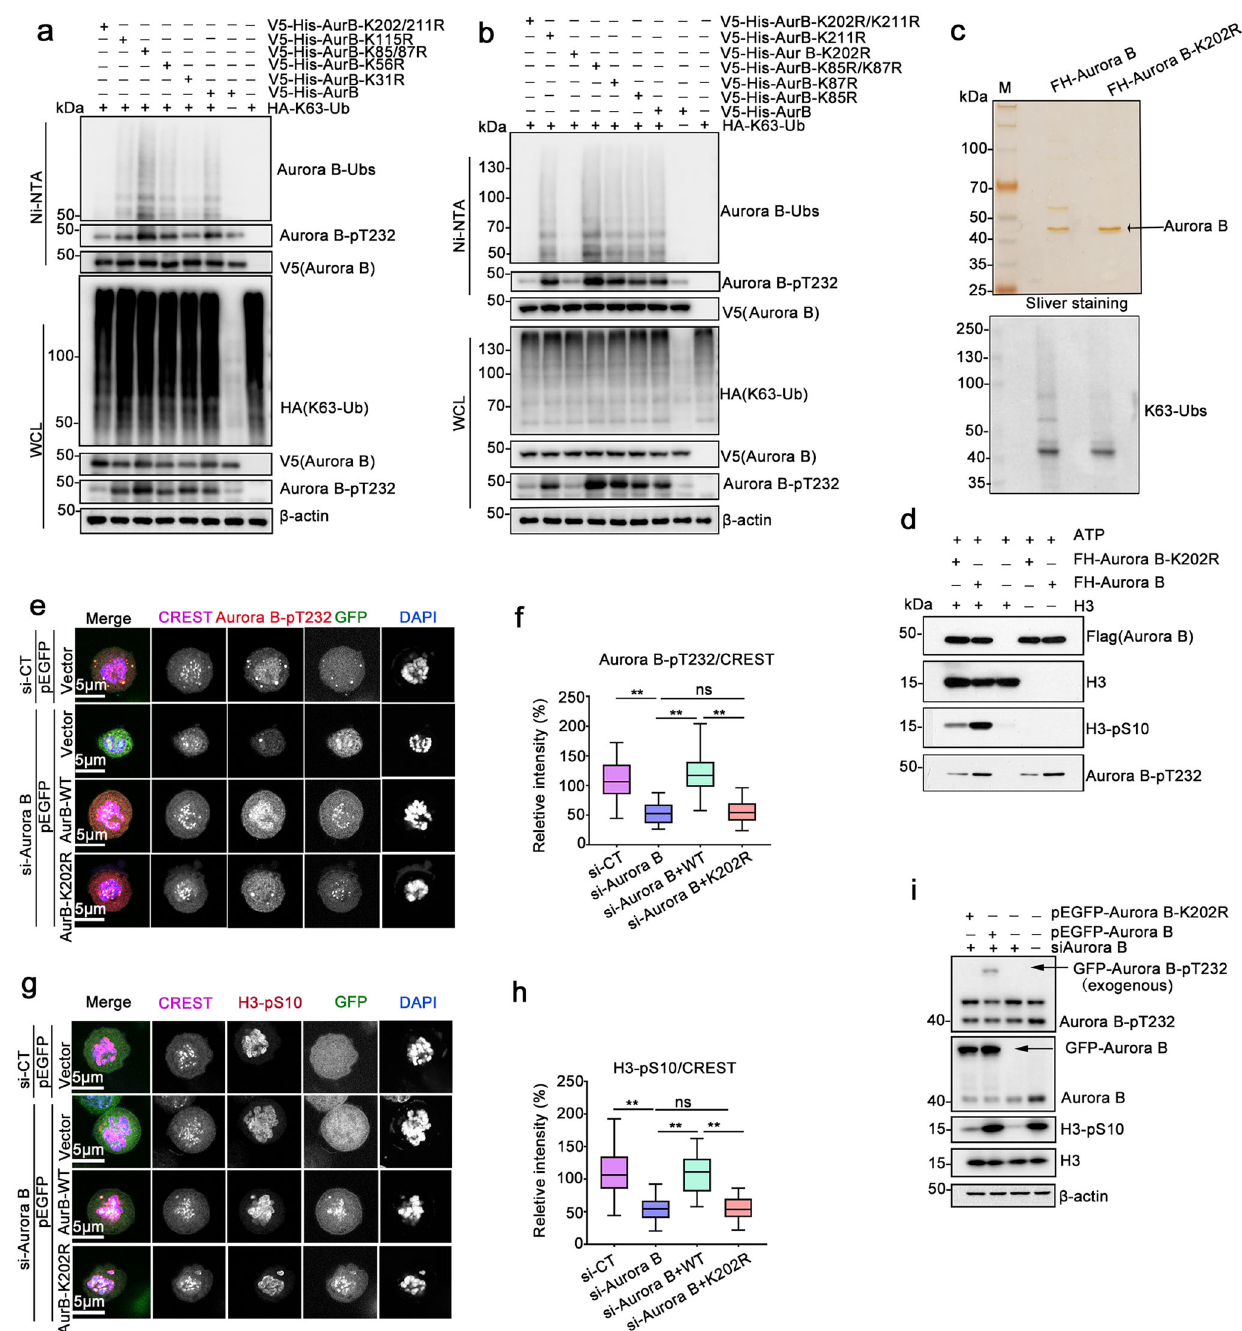
Fig. 4 K63-linked ubiquitination at Lys202 is required for Aurora B kinase activity. a , b K202 is the main ubiquitination site on Aurora B. HEK293T cells were co-transfected with the indicated plasmids and treated with 30 ng/mL NOC for 16 h. Mitotic cells were subjected to Ni-NTA pull-down under denaturing conditions. V5-His-Aurora B pull-downs were analyzed by immunoblotting with the indicated antibodies. c Immunoprecipitations used in the in vitro kinase assay. FH-Aurora B or FH-Aurora B-K202R was puri fi ed from mitotic HEK293T cells using Flag-M2 agarose beads, resolved by SDS – PAGE and silver staining (upper), and immunoblotted with anti-K63-Ub antibody (bottom). d In vitro kinase assay was performed using the puri fi ed Aurora B complex shown in c , in the presence of ATP. H3 was used as the substrate of Aurora B. e – i Aurora B-K202R has lower kinase activity in vivo. Representative confocal images showing Aurora B-pT232 ( e ) or H3-pS10 ( g ) intensity in cells transfected with pEGFP-Aurora B or pEGFP-Aurora B-K202R. Endogenous Aurora B was silenced by siAurora B in HeLa cells, followed by co-transfection with the indicated plasmids. Then cells were synchronized with 30 ng/mL NOC, fi xed, and stained with the indicated antibodies. Aurora B-pT232, red; CREST, purple; DAPI, blue; H3-pS10, red. Bar, 5 μ m. f , h Box-and- whiskers plots showing the quanti fi cation of the relative intensity of Aurora B-pT232 or H3-pS10 as shown in e and g , respectively. Intensities were normalized to the general kinetochore marker CREST. Boxes show the upper and lower quartiles with a line at the median. Whiskers as the extent of 100% of the data. Data are shown as means ± SD ( n = 15 cells, and six areas for each cell were counted). ** p < 0.01 versus CT, one-way ordinary ANOVA test, analyzed by GraphPad Prism 8. Experiments were repeated at least three times. i Protein samples from cells treated as shown in e and g were analyzed by western blotting. Actin was used as a loading